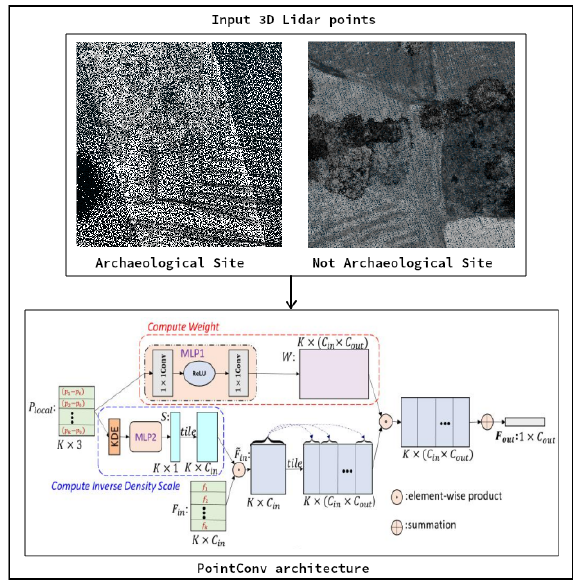
Figure 3. 3D PointConv model with input LIDAR data examples for Maya archaeological site classification is shown.